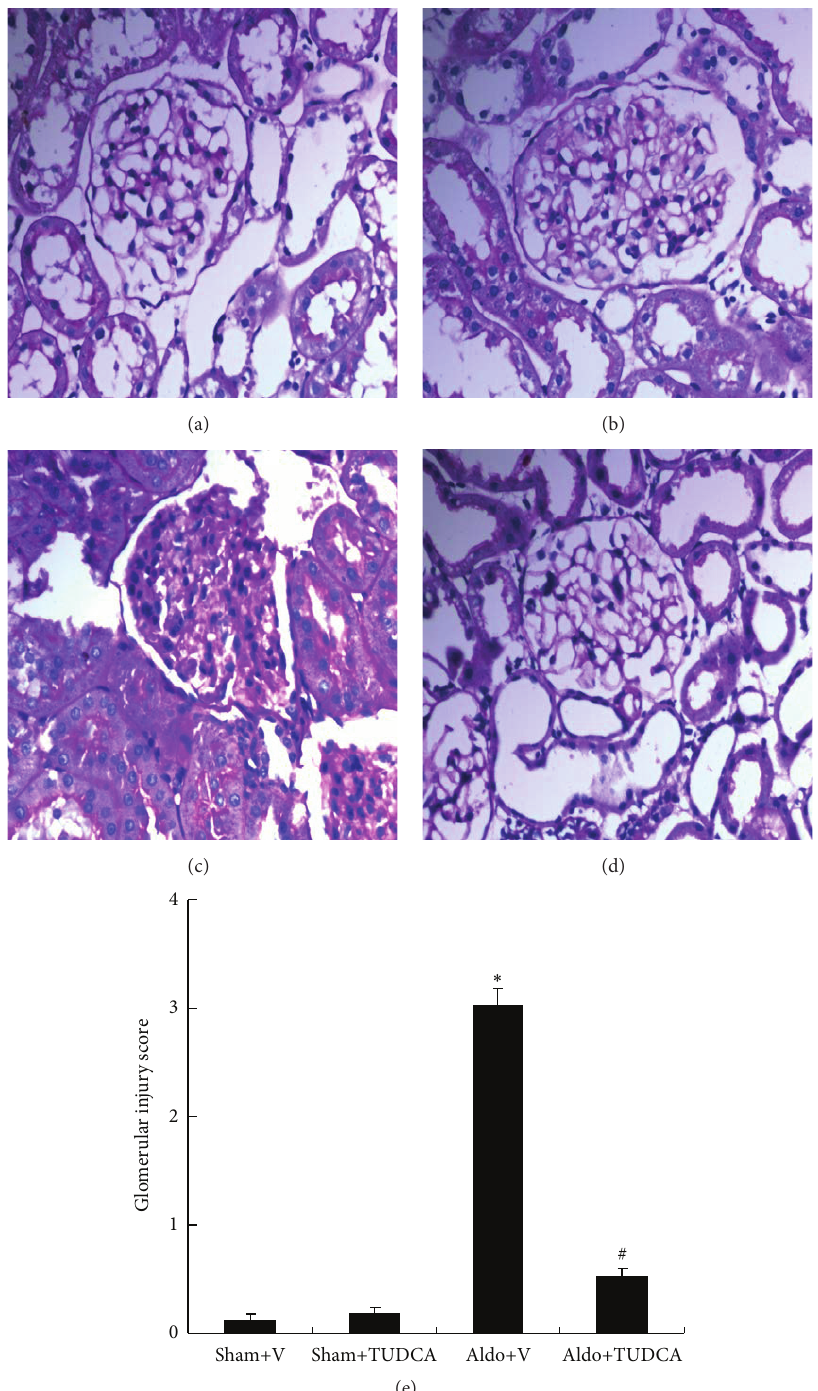
Figure 1: Physiologic parameters of the mice at the end of week 4. Representative photomicrographs (magnification: 400x) of PAS-stained renal injury. (a) Sham+V group; (b) Sham+TUDCA group; (c) Aldo+V group; (d) Aldo+TUDCA group; (e) Glomerular Injury Score. ∗ 𝑝 < 0.05 , Sham+V group versus Aldo+V group, # 𝑝 < 0.05 , Aldo+V group versus Aldo+TUDCA